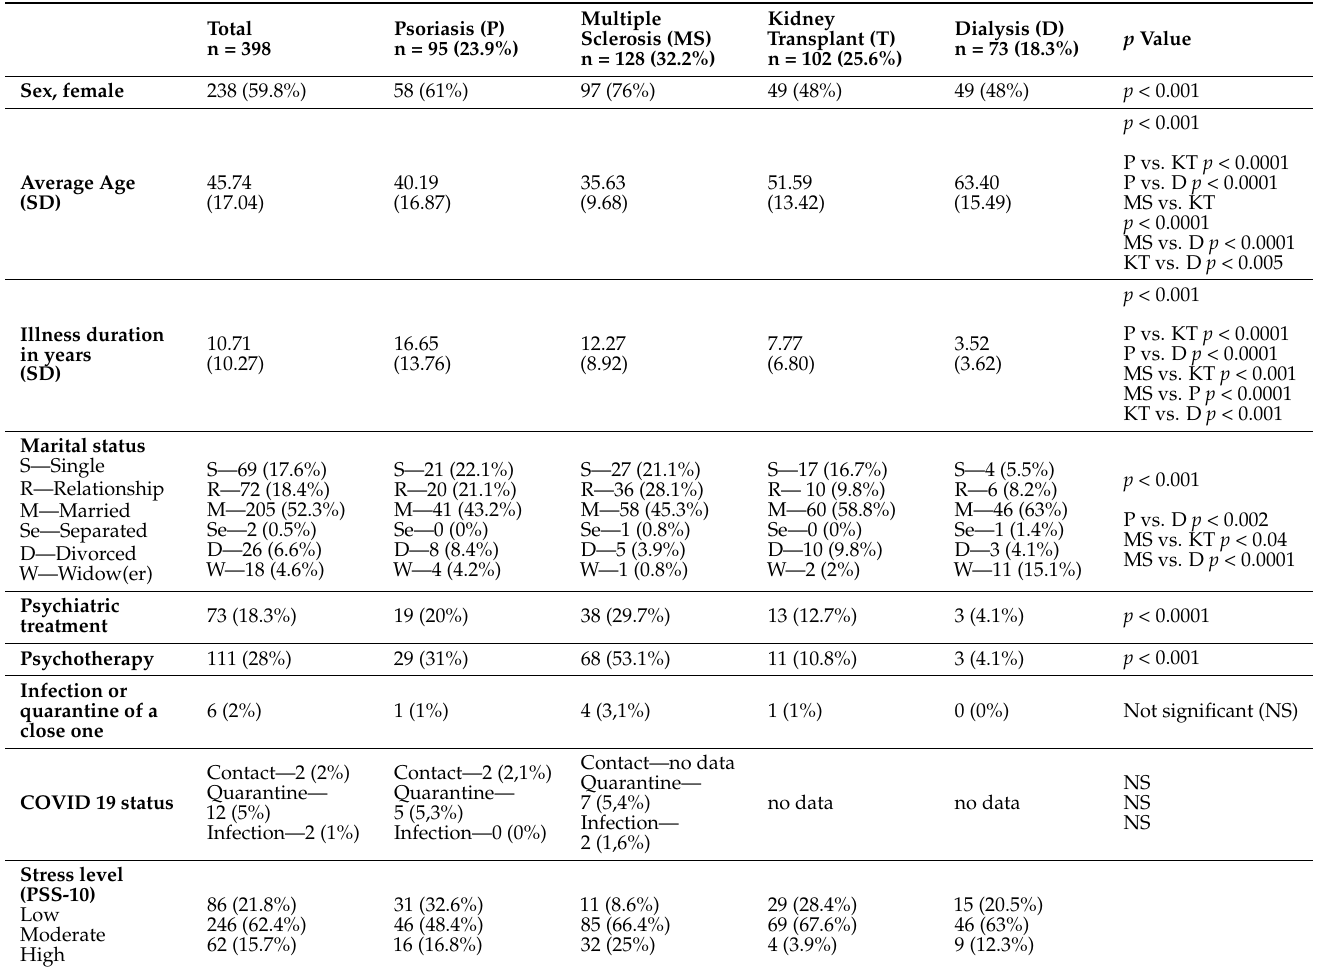
Table 1. Detailed sociodemographic data.